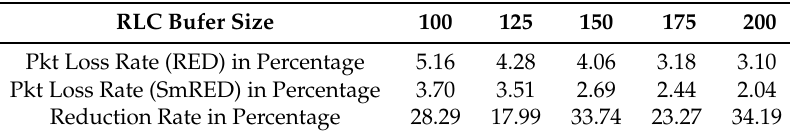
Table 3. Packet Loss Rate in the Moderate Traffic Load